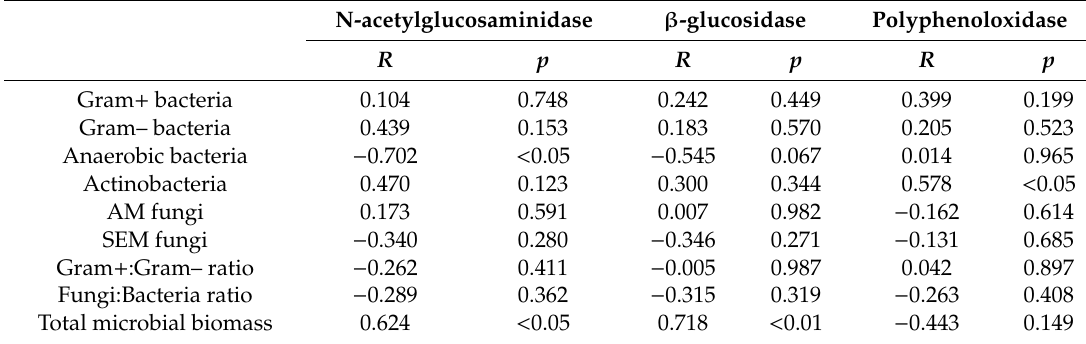
Table 4. Pearson’s correlation coe ffi cient ( R ) and p values of regression between soil microbial group phospholipid fatty acids (PLFAs) and microbial extracellular enzyme activities.